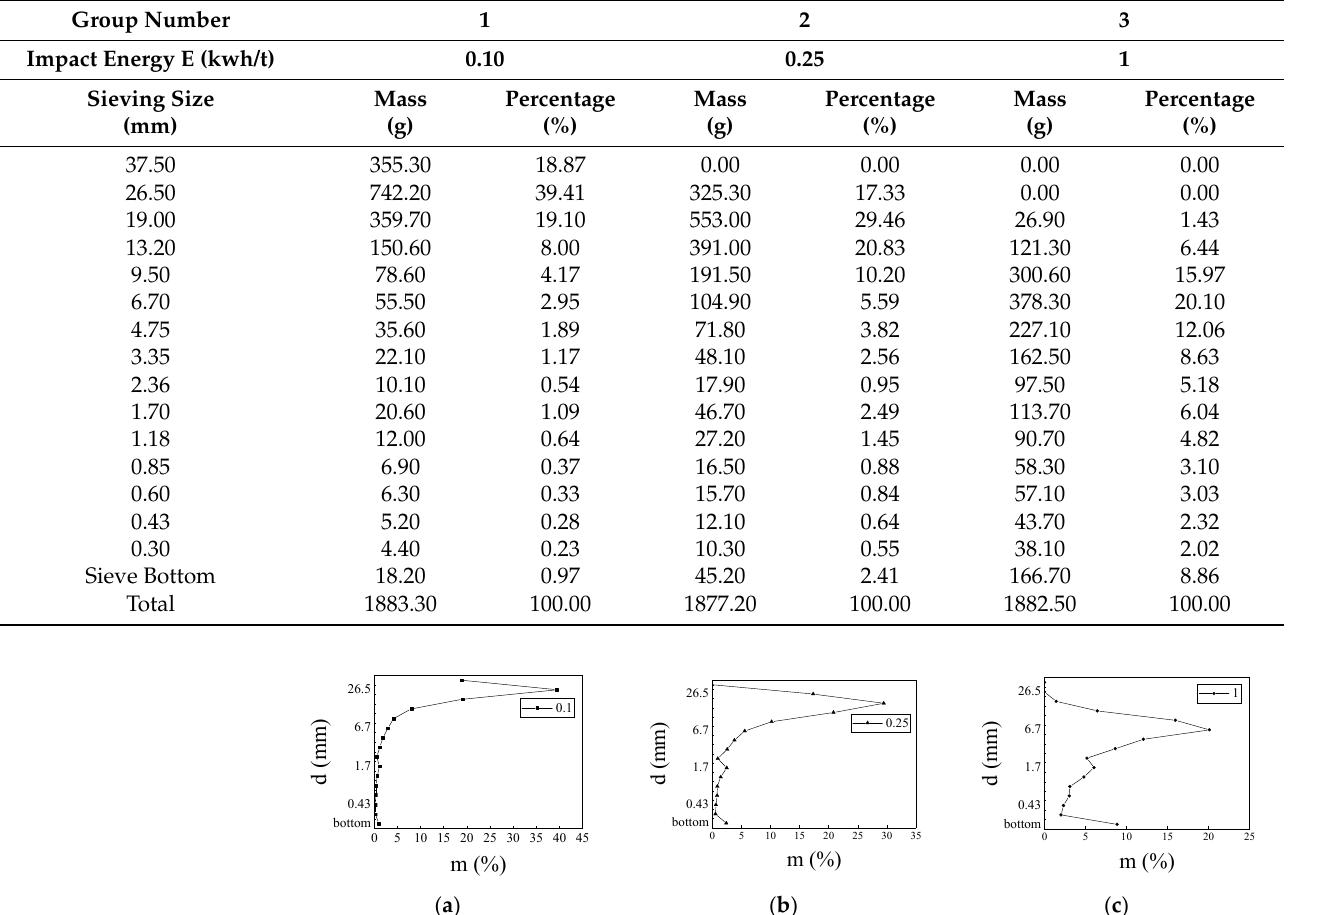
Figure 5. Histogram of crushed particle size and mass distributions under different impact energies. ( a ) E = 0.1 kwh/t; ( b ) E = 0.25 kwh/t; ( c ) E = 1 Table 2. Drop weight test particle size distribution.